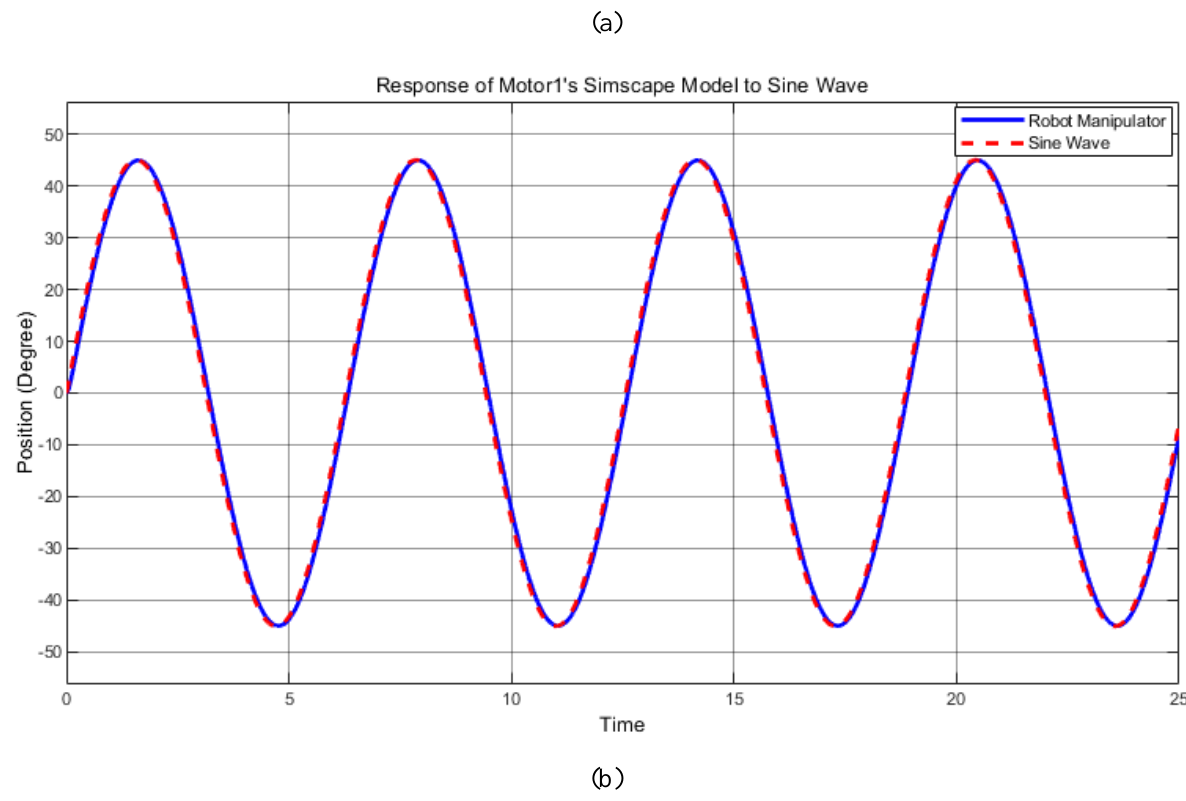
Figure 11. Joint 1 response a) step input, b) sinus